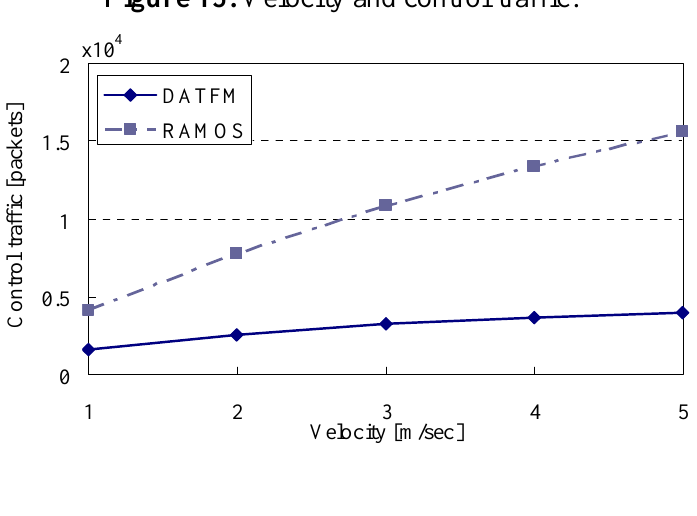
Figure 15. Velocity and control